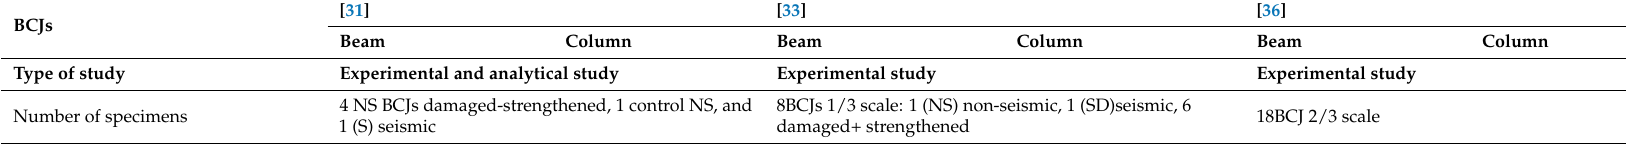
Table 4. Summary of experimental work on scaled-down BCJs externally reinforced with